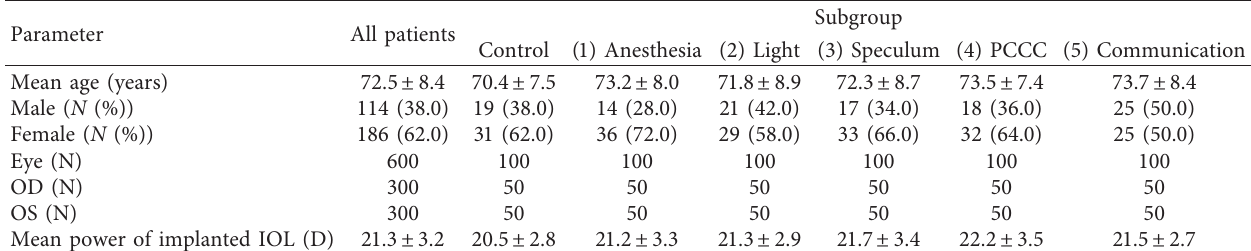
Table 1: Baseline and demographic data of the study population. Parameter All patients